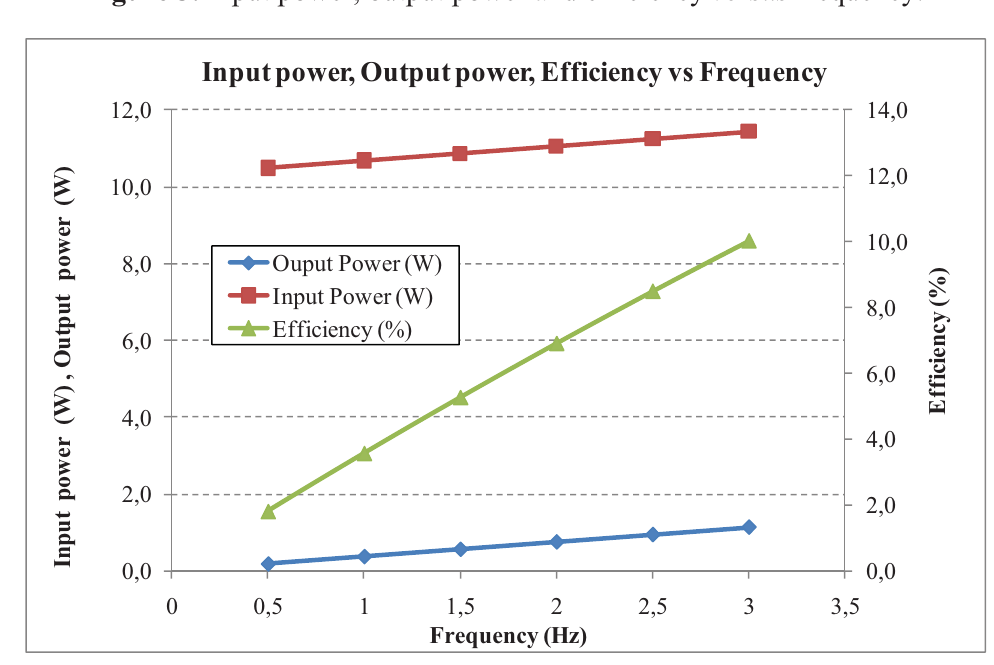
Figure 3. Input power, output power and efficiency versus